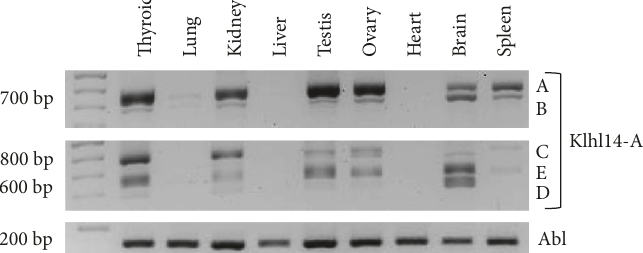
Figure 2: Klhl14-AS isoform expression in adult mouse tissues. Klhl14-AS transcripts were ampli fi ed by RT-PCR on total RNA from adult mouse organs. Three di ff erent PCR reactions were performed on the same template cDNA. Upper image: A and B isoforms were ampli fi ed by using the oligo set 1; middle image: C, D, and E were obtained by using oligo set 2; lower image: Abelson (Abl) ampli fi cation was performed as the control (for details see Materials and Methods). Data are representative of three independent